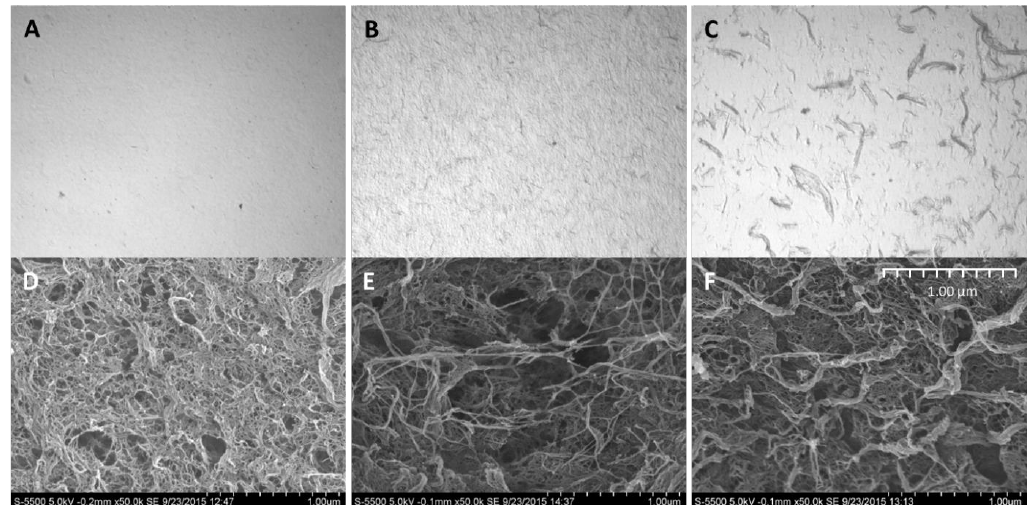
Figure 5. Microscopy of hydrogels of M. pyrifera alginate (1% ( w / v )) ( A ), and composite gels with 0.30% mechanically fibrillated ( B ), and 0.30% oxidized CNF ( C ) at 40 × magnification. SEM images of supercritically-dried gels of the same composition ( D – F ).